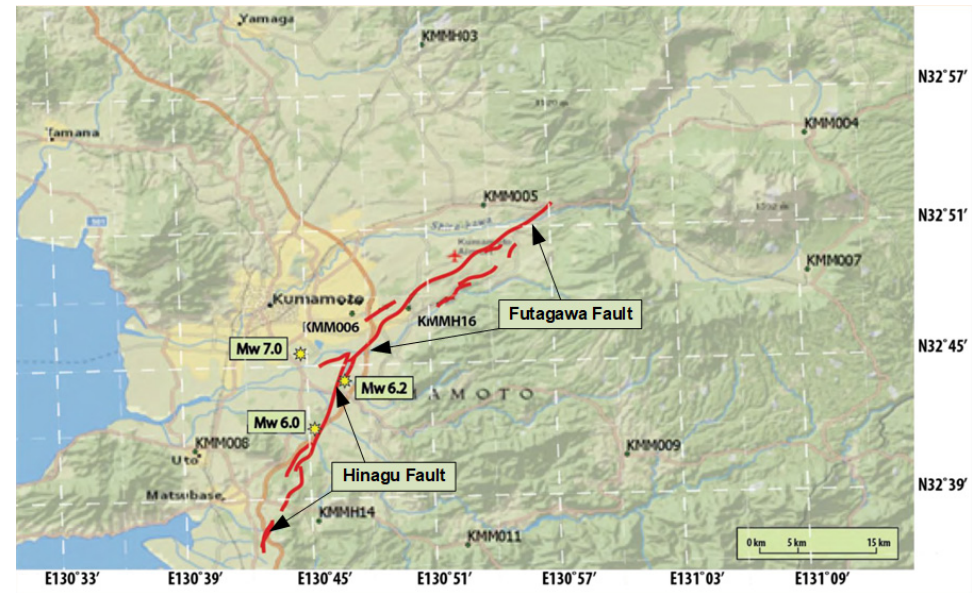
Figure 4. Map of the foreshock and mainshock epicenters, the Futagawa and Hinagu faults, and the ground motion recording stations listed in Table 1. Red lines represent faults, stars represent epicentral locations for earthquake events in the 2016 KES.